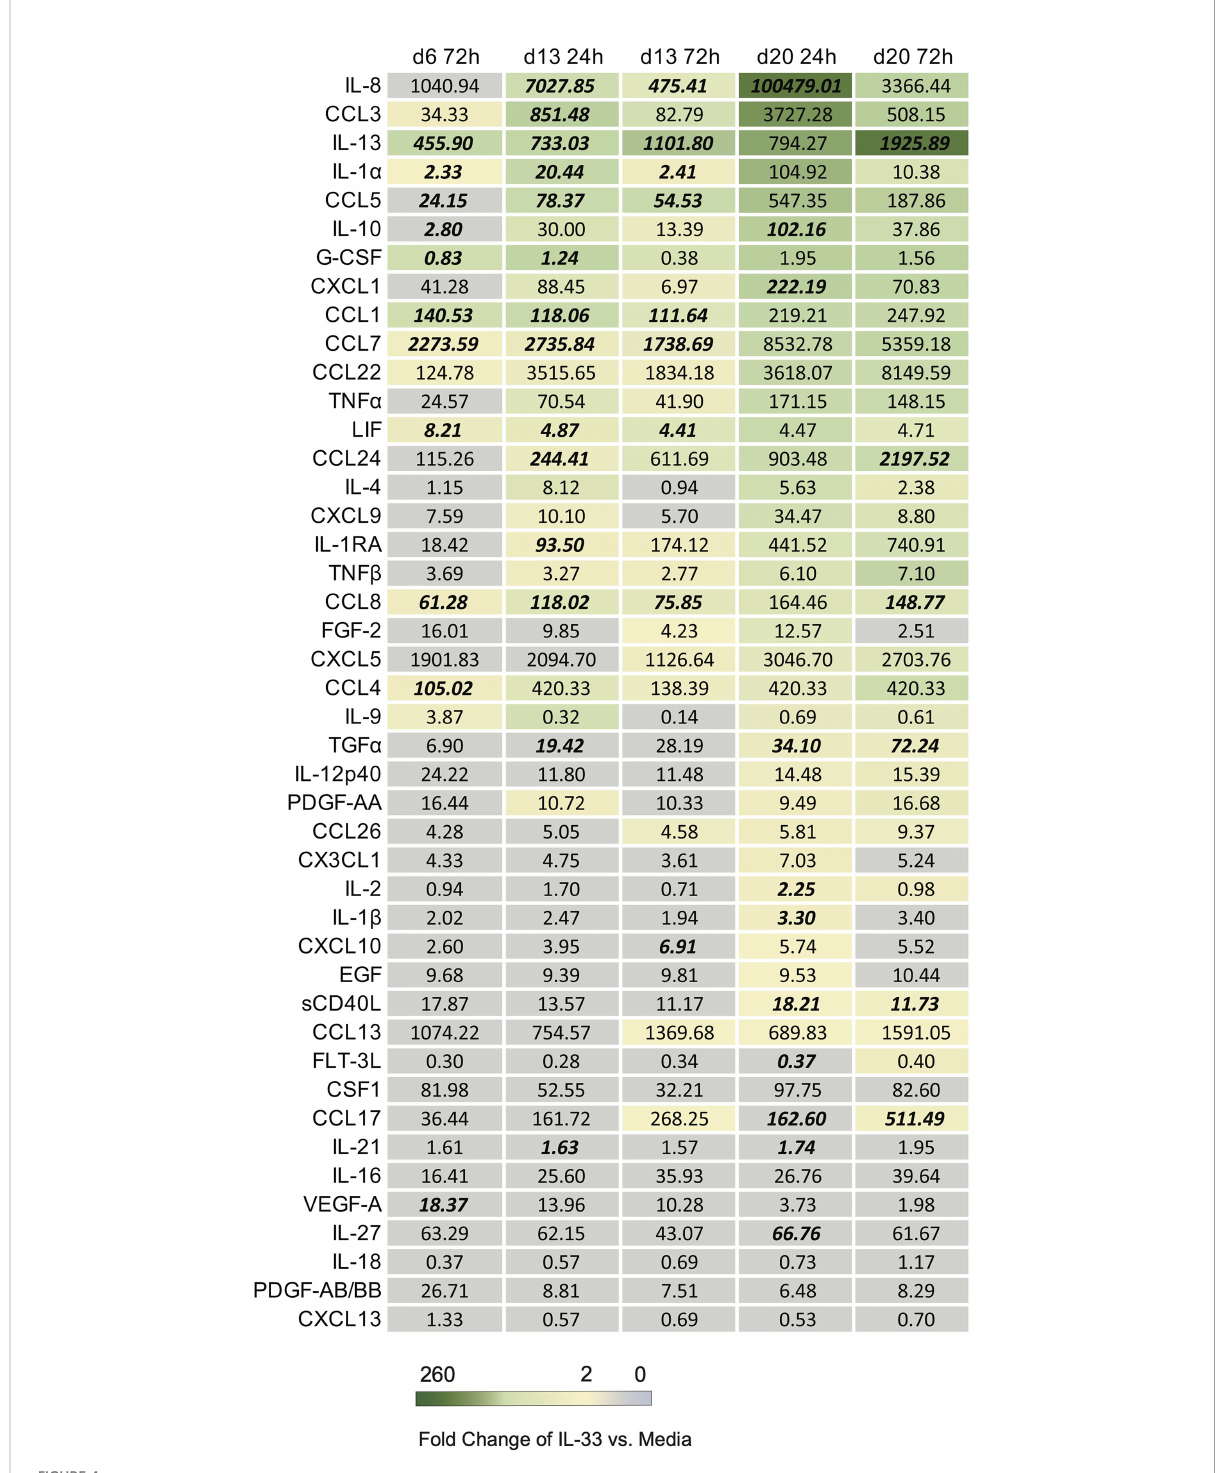
FIGURE 4 List of downstream cytokines produced in response to IL-33 in differentiated eosinophils. The geometric mean concentration of each cytokine in the IL-33 treated condition is shown numerically. A color gradient displays the level of fold change in concentration of IL-33 treatment relative to media control. Any cytokine with a fold change greater or equal to 2 was assigned color. Cytokines with a fold change less than 2 were left grey. The concentrations of cytokine from each donor and stimulus condition were transformed and plotted as Z-scores to account for varied scale between individuals. Cytokines at timepoints with statistically signi fi cant p values based on Z-scores in response to IL-33 compared to media control are bolded and